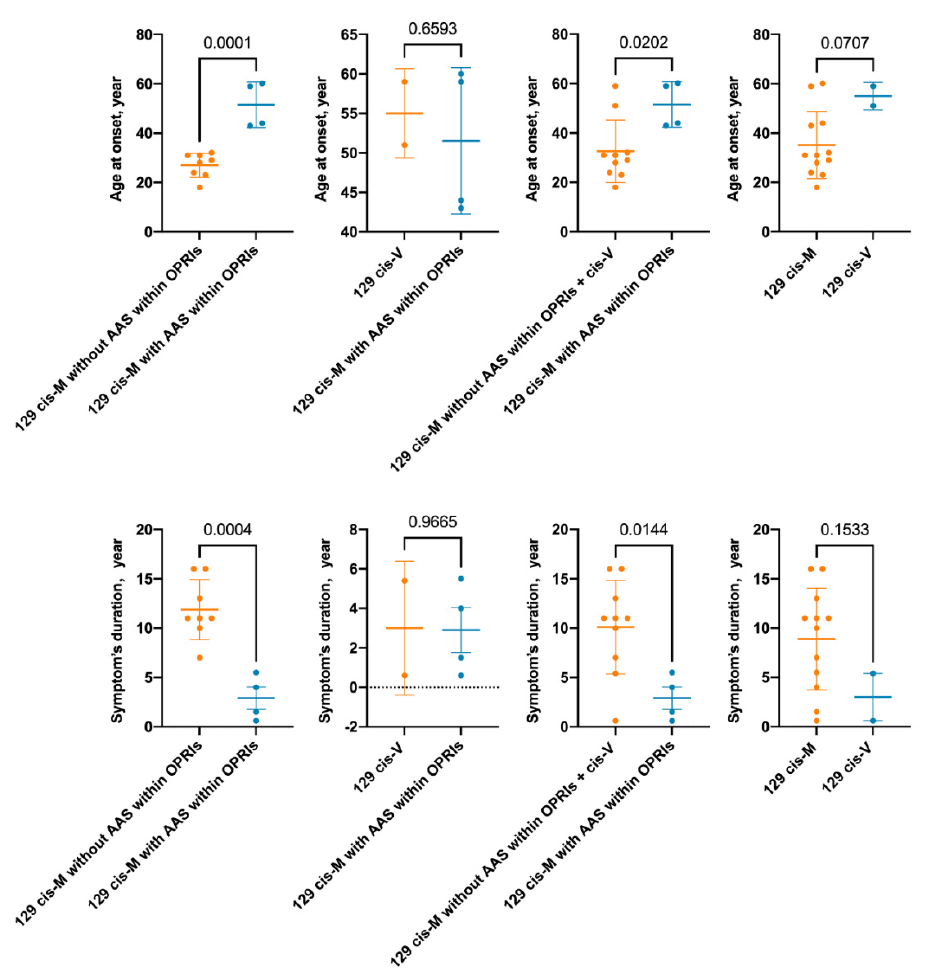
Figure 4. Comparison of age at onset and duration of symptoms in patient groups demarcated by codon 129 genotype and ASS within OPRIs. ASS, amino acid substitution; OPRIs: octapeptide repeat insertions.